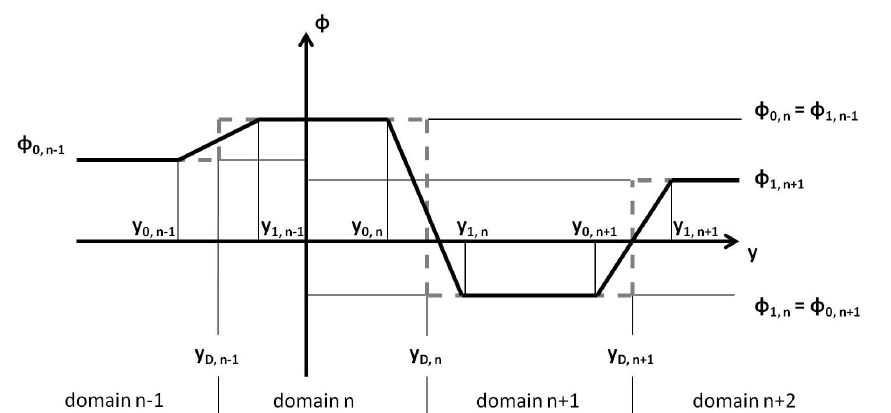
Figure 15. DLSME model—Behavior of the angle φ between B T ( y ) and the fixed fiducial z -direction (equal for all domains) inside Π ( y ) . The solid black line is the new smooth version, while the broken gray line represents the usual jump of B T ( y ) from one domain to the next in the DLSHE model. The horizontal solid and broken lines partially overlap. For illustrative simplicity, we have chosen the same length for all domains. The blazar is on the extreme left of the figure while the observer is on the extreme right. (Credit